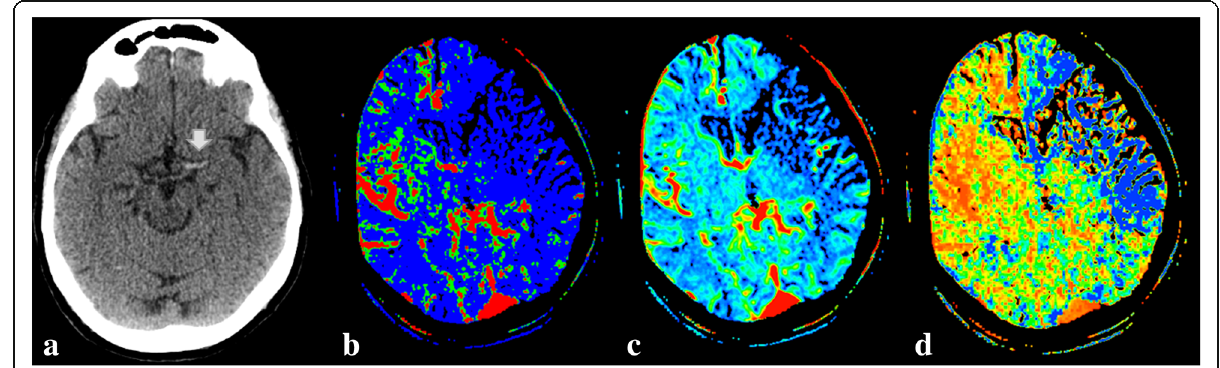
Fig. 6 This 75-year-old woman presented with right hemiplegia and aphasia. Axial unenhanced CT shows a hyperdense vessel sign in the left MCA M1 segment ( a , white arrow). CT perfusion was also performed, with parametric maps indicating CBF ( b ), CBV ( c ), and mean transit time (MTT) ( d ). These images reveal a large established core infarct with no significant penumbra. This indicates a complete stroke; no